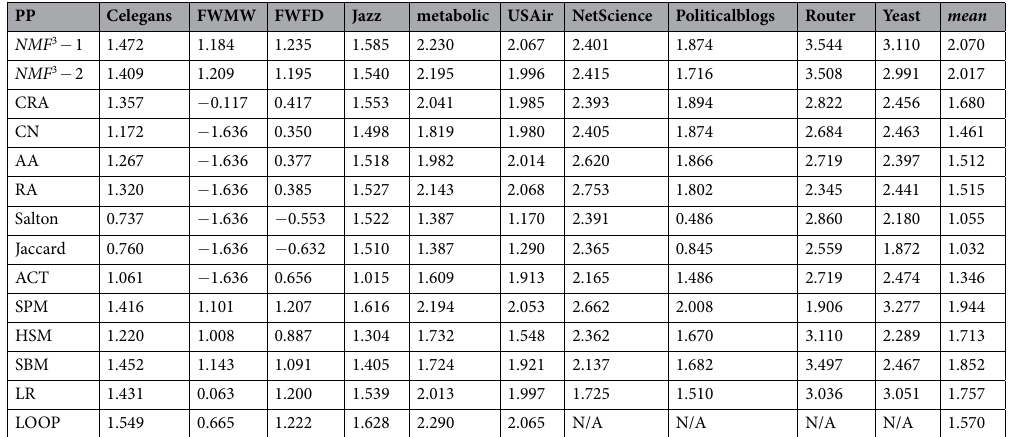
Table 4. Link prediction accuracy measured by Prediction-Power on the 10 real networks. We compared our methods ( NMF 3 − 1, NMF 3 − 2) with other methods on the 10 network data sets and the AUC are returned with an average run of over 100 times. For each data set, the presented links are partitioned into training set (90%) and test set